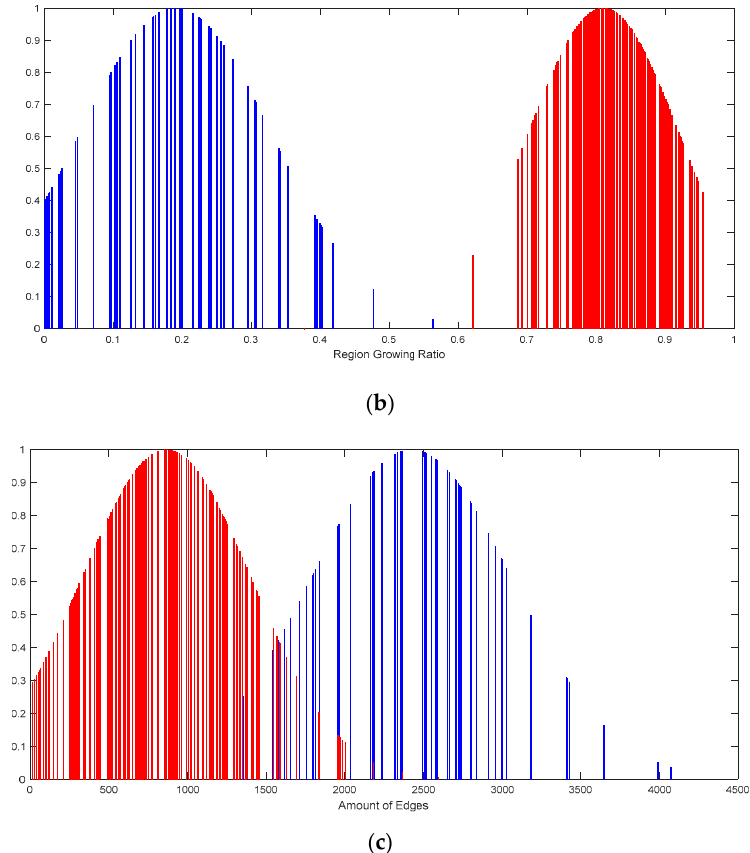
Figure 18. Parallel parking training set. ( a ) Scatter plot of features; ( b ) Gaussian distribution of region growing ratio; ( c ) Gaussian distribution of number of edges.